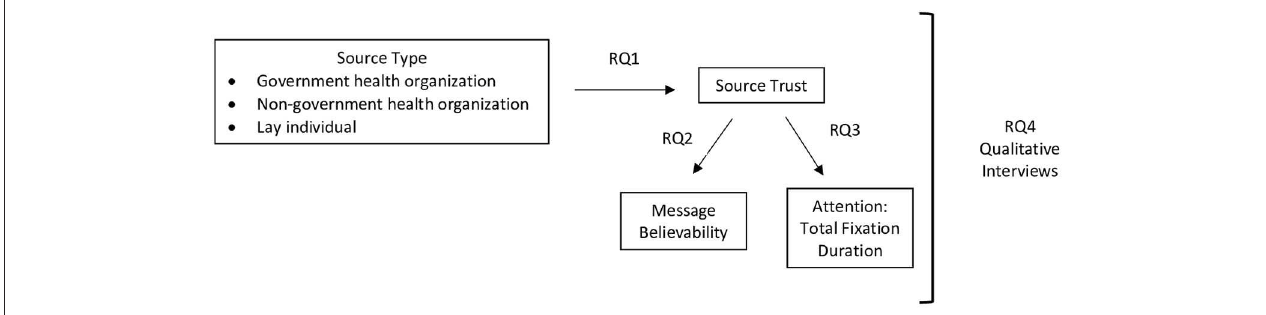
FIGURE 1 | Conceptual model examining individuals’ trust assessment of source on message believability and information processing of simulated cancer-related Facebook